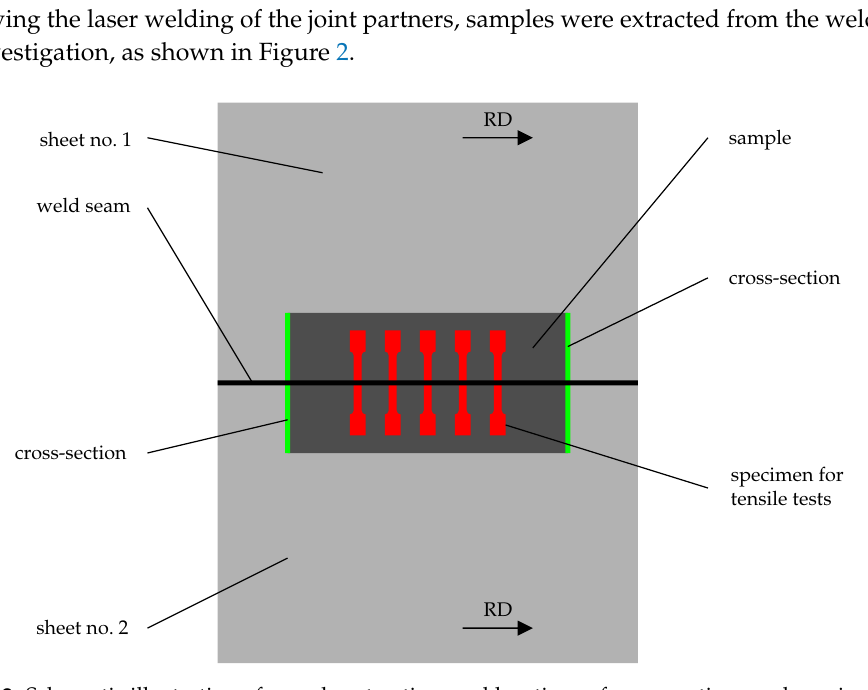
Figure 2. Schematic illustration of sample extraction, and locations of cross-sections and specimens for tensile testing with rolling direction (RD) of the sheet